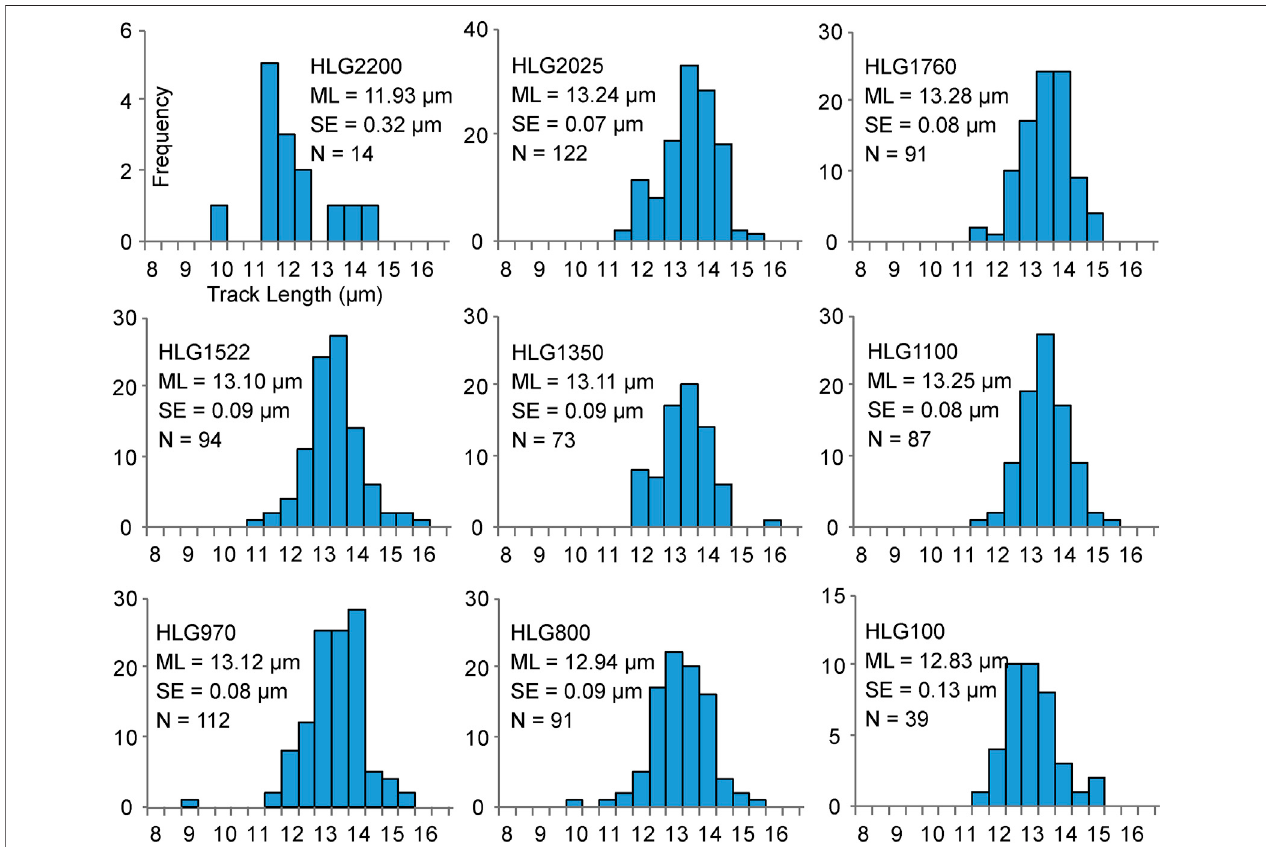
FIGURE 6 | Track length (c-axis corrected) distribution histograms. M, Mean track length; SE, Standard error; N, Number of tracks.